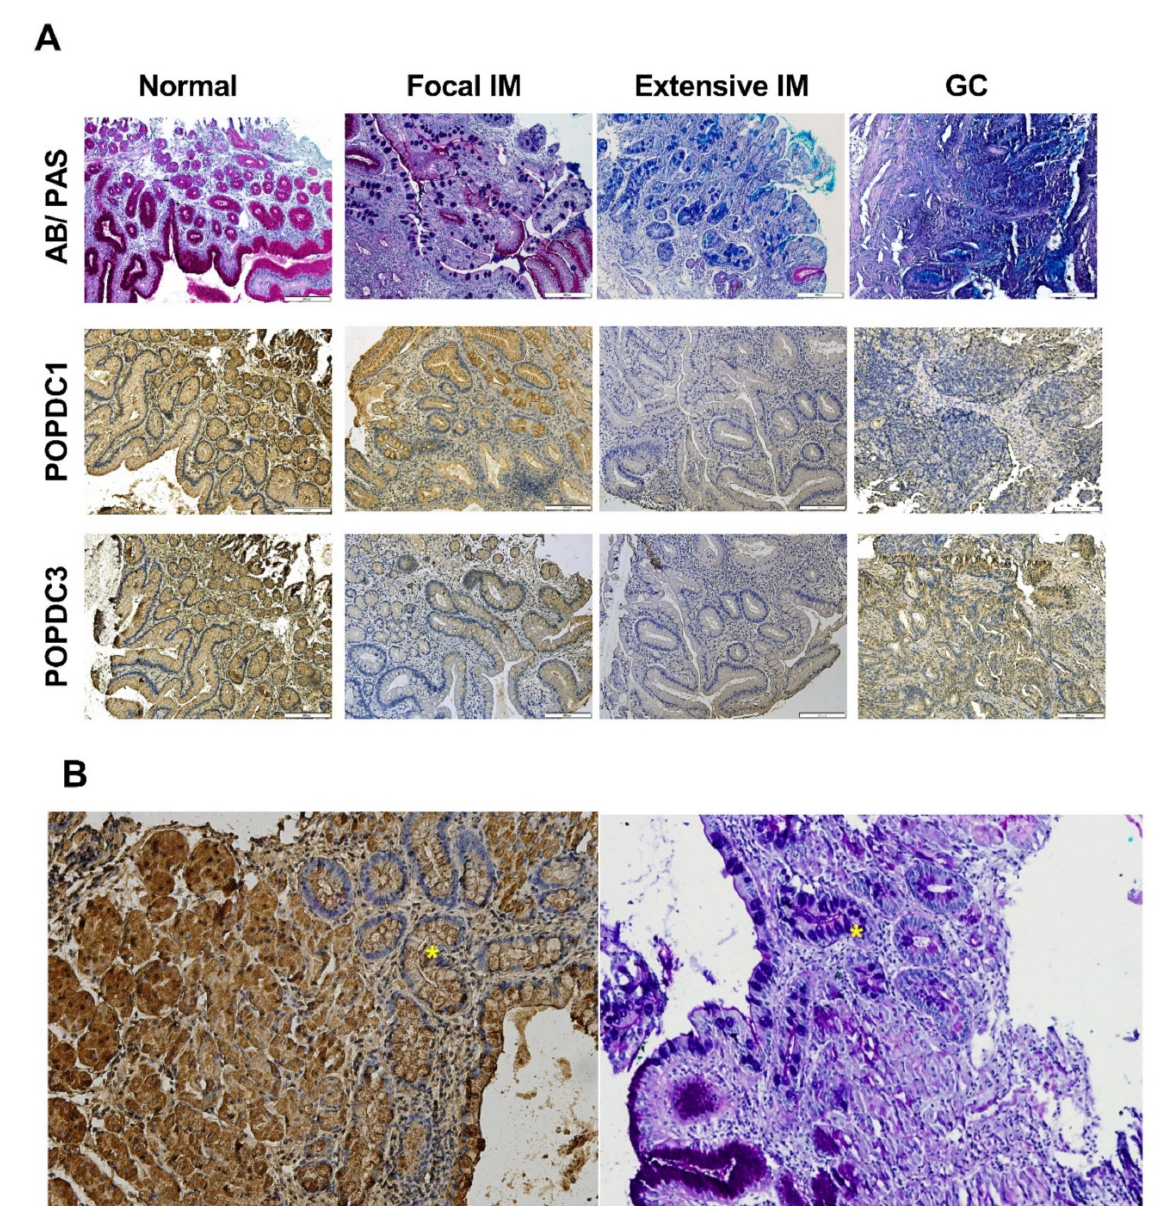
Figure 1. Representative biopsy microsections. ( A ) The four tissue categories stained for mucins (AB/PAS, purple) and immunostained for POPDC1 and POPDC3 . The mucus in goblet cells in IM stain magenta for neutral mucins and bright blue for acid mucin. The brown color represents protein immunolabeling of POPDC1 and POPDC3 . Acidic mucins appear in blue and neutral mucins in red; mixed mucins appear purple. The images shown are not serially overlapping. Note reduced labeling intensity of POPDC1 and POPDC3 in the IM and GC tissues. X20 magnification. ( B ) A transitional region from normal phenotype to IM (yellow asterisks). Left, POPDC1 immunolabeling; right, mucin AB/PAS staining. Note typical morphology and reduced POPDC1 labeling in the IM region. The bar indicates 100 µ